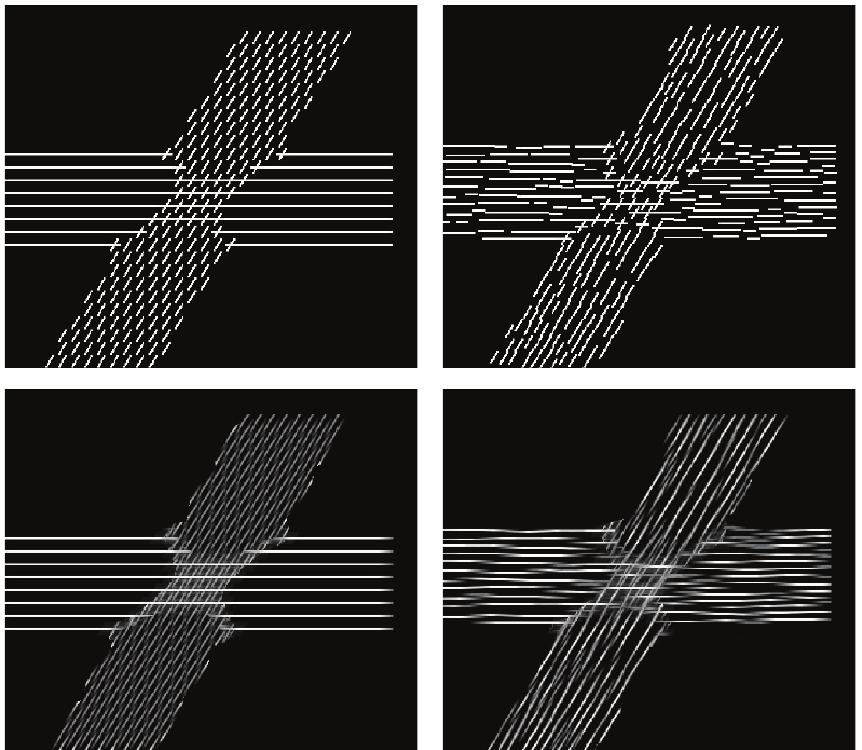
Figure 5: Comparison of cylindrical glyph samples (top) and LIC results (bottom) with sample placement on a regular grid (left) and continuous placement (right). The synthetic dataset contained two 5 mm thick fibers crossing at an angle of 60 ∘ . The cylindrical input patterns had a length of 12 subvoxels and a width of